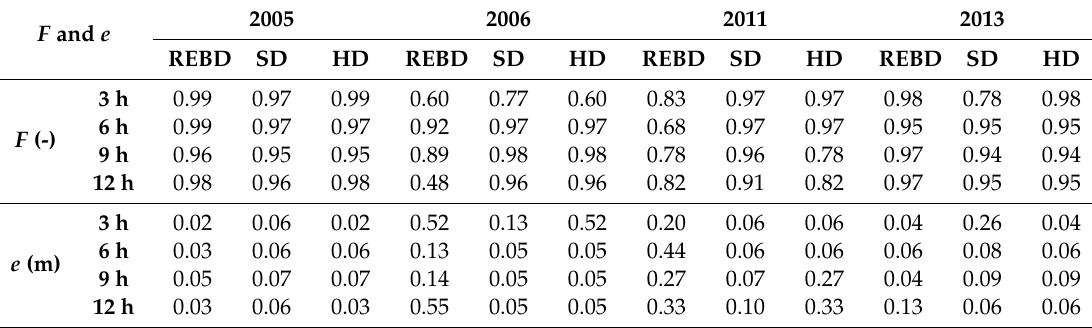
Table 3. Average Fitstatistic and absolute error for each time interval using the three databases REBD, SD, and HD for the validation events of 2005, 2006, 2011, and 2013. F and